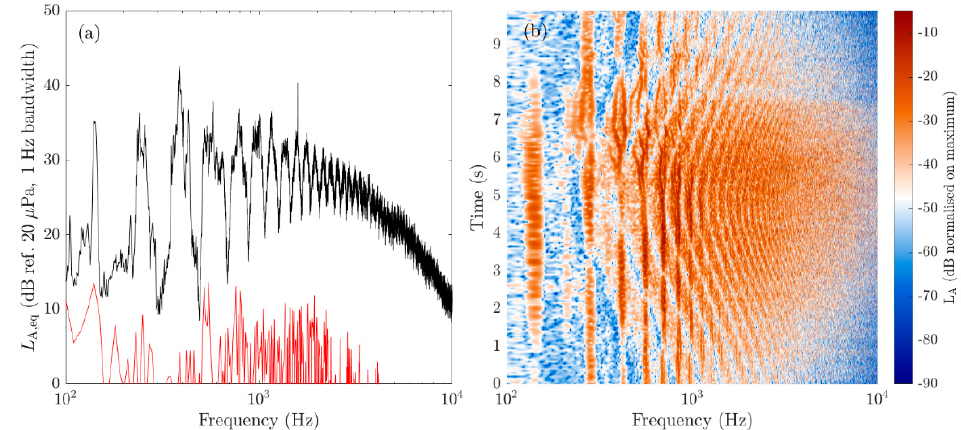
Figure 1. ( a ) L A,eq spectrum produced by a hovering DJI Matrice UAV (black) with a representative background spectrum also shown (red); ( b ) A-weighted SPL spectrogram produced by a DJI Matrice in flyby. For both cases, the UAV was at a height 10 m above flat grass-covered ground and the noise was measured by a microphone 1.2 m above the ground and 10 m horizontally from the UAV position/flight path.